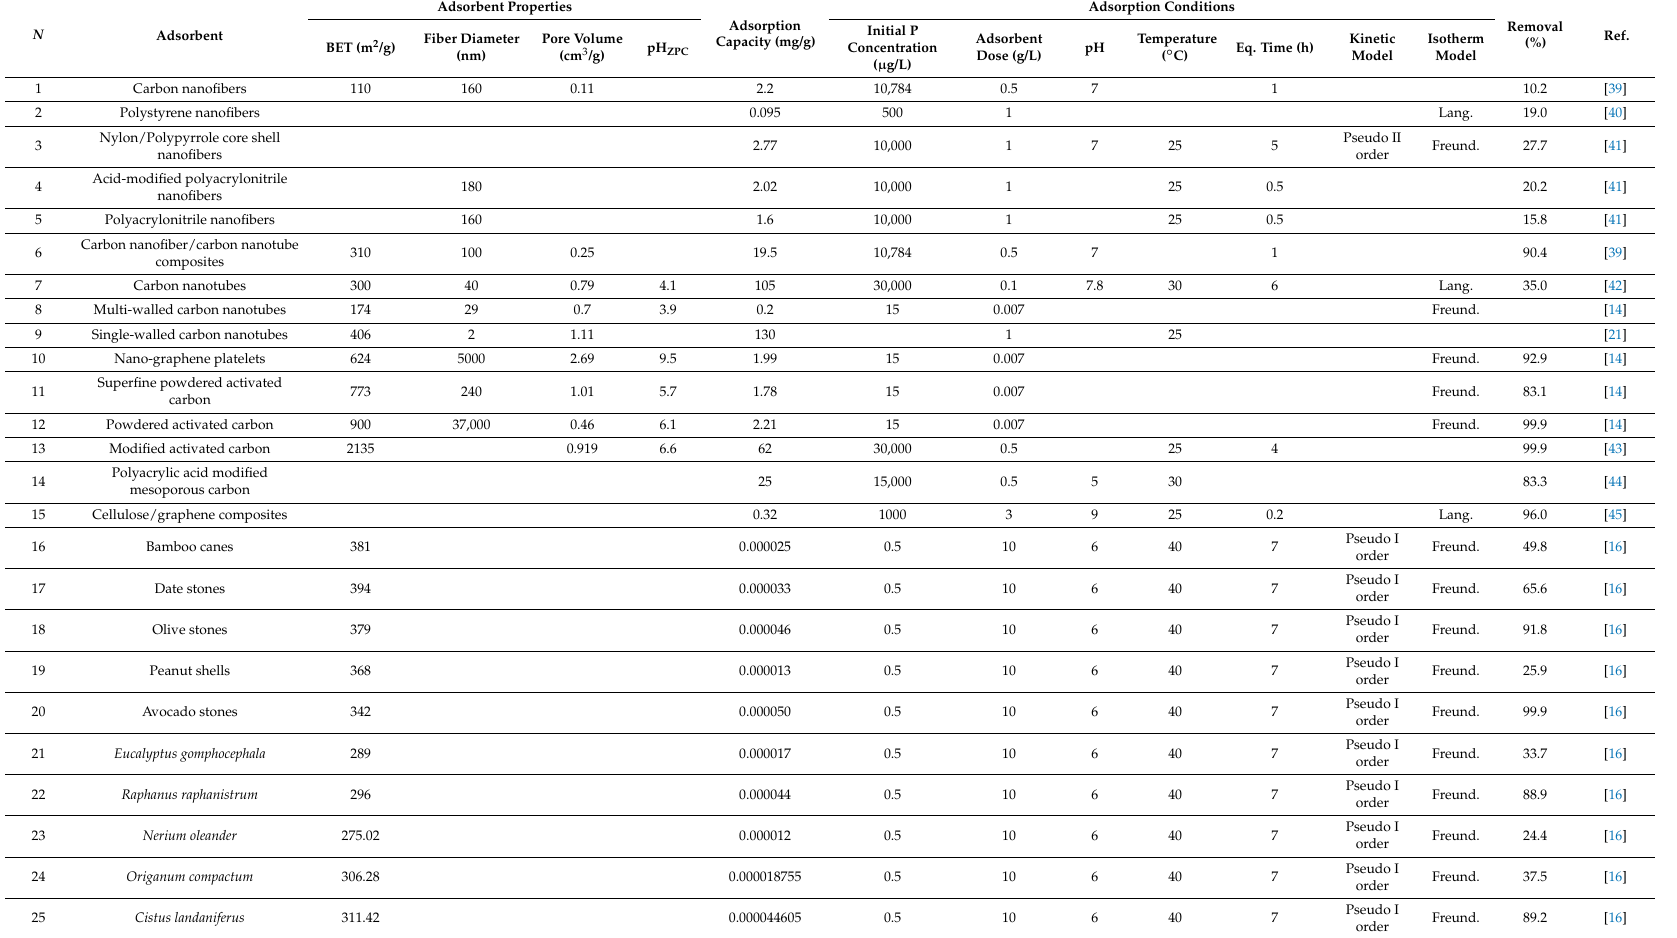
Table 4. Nanofibrous adsorbent properties and adsorption conditions for the removal of